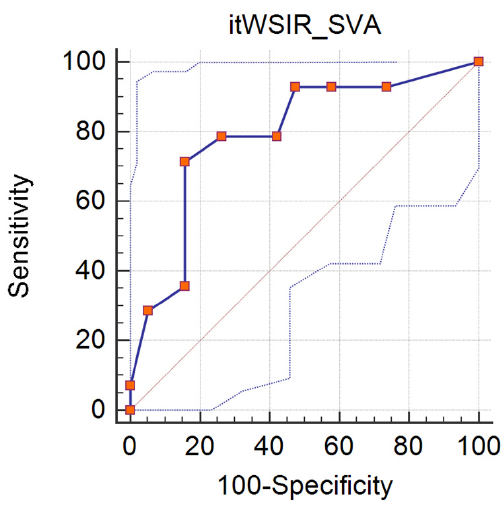
Figure 8. ROC curve for Italian WSIR SVA screening task (distinction between morphosyntactic risk, n = 14, and no risk, n = 19), AUC =